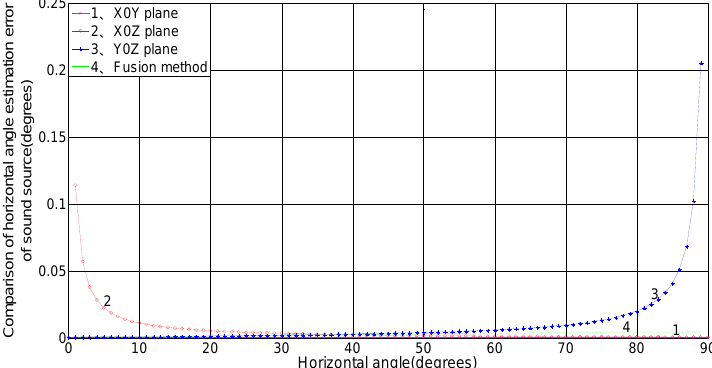
Figure 4. Comparison and analysis of the horizontal angle estimation error of the sound source caused by a horizontal angle change.